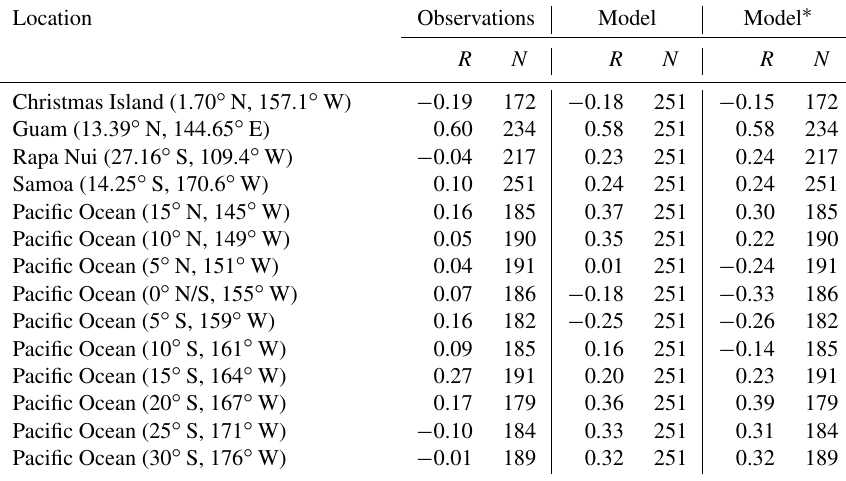
Table 5. Pearson correlation ( R ) and number of data points ( N ) for bimonthly averaged CO values versus the MEIv2 index. In the “Observa- tions” column, we show the calculation for observed CO versus MEIv2. Under “Model”, we show the corresponding calculation considering the continuous series of CO values simulated with the model. Under “Model ∗ ”, we consider model outputs only for those cases when there are CO observations.